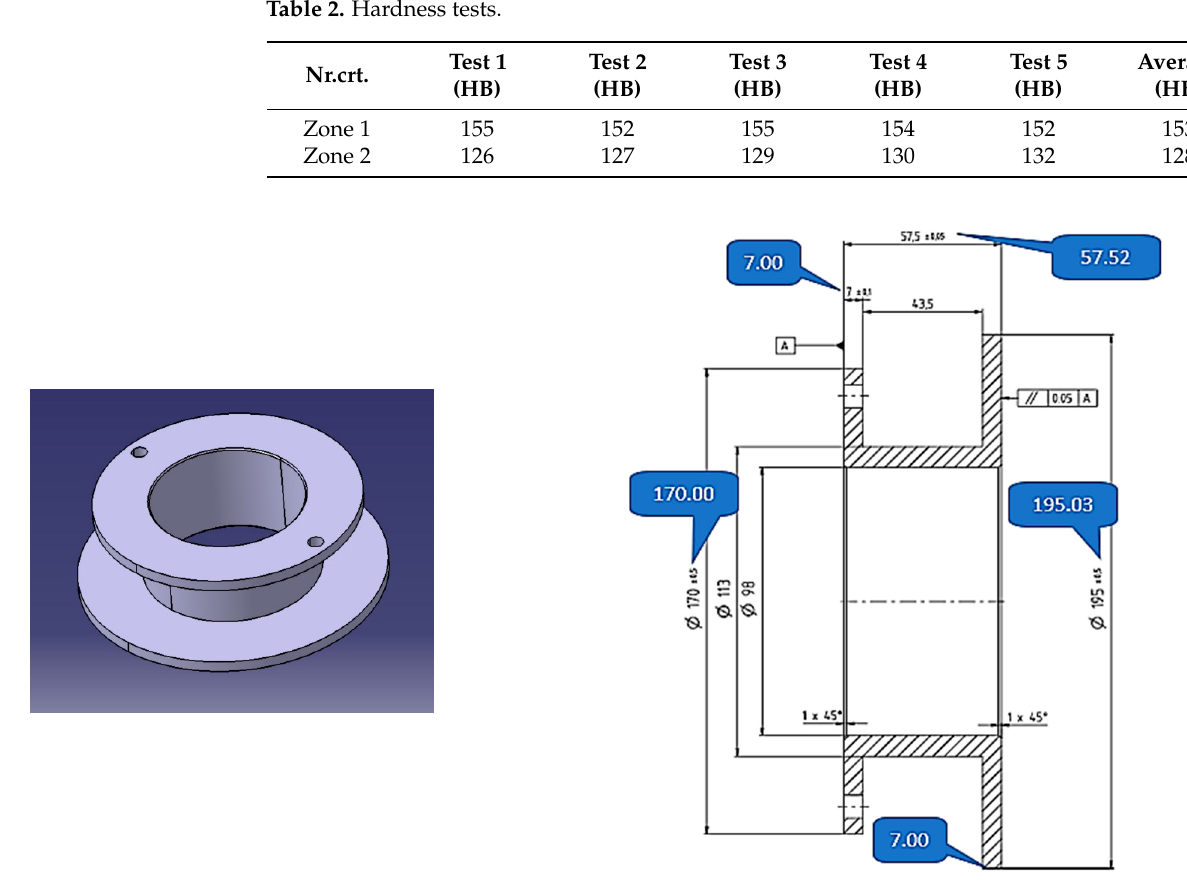
Figure 14. Measured part hardness values in different zones.